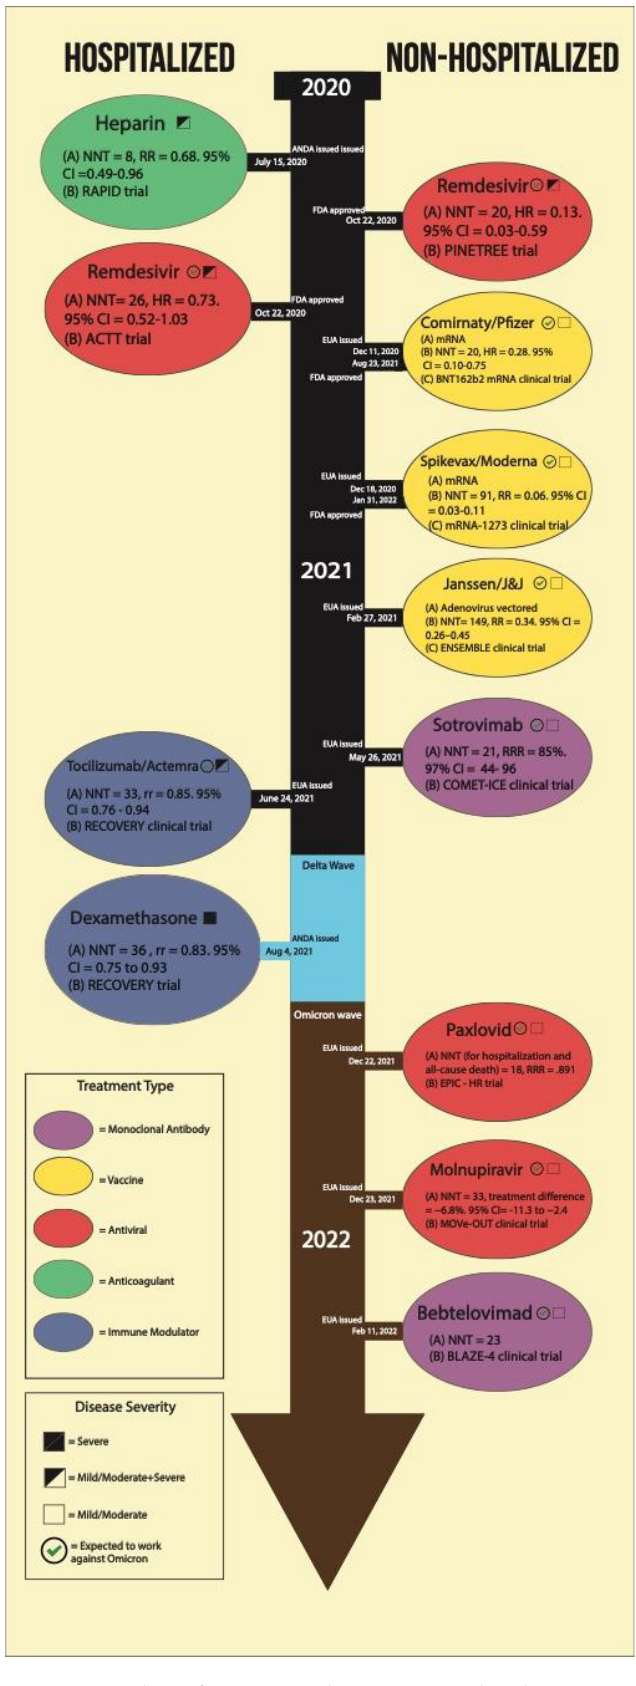
Figure 2. Timeline of COVID-19 therapeutics and authorization use issuance at the